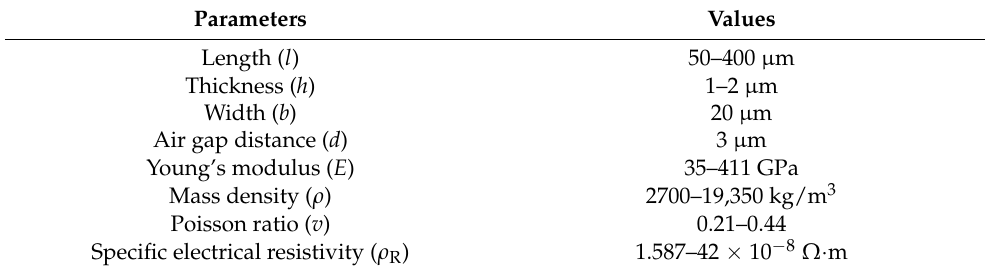
Table 1. Geometrical and material parameters of the considered metallic MEMS cantilevers.